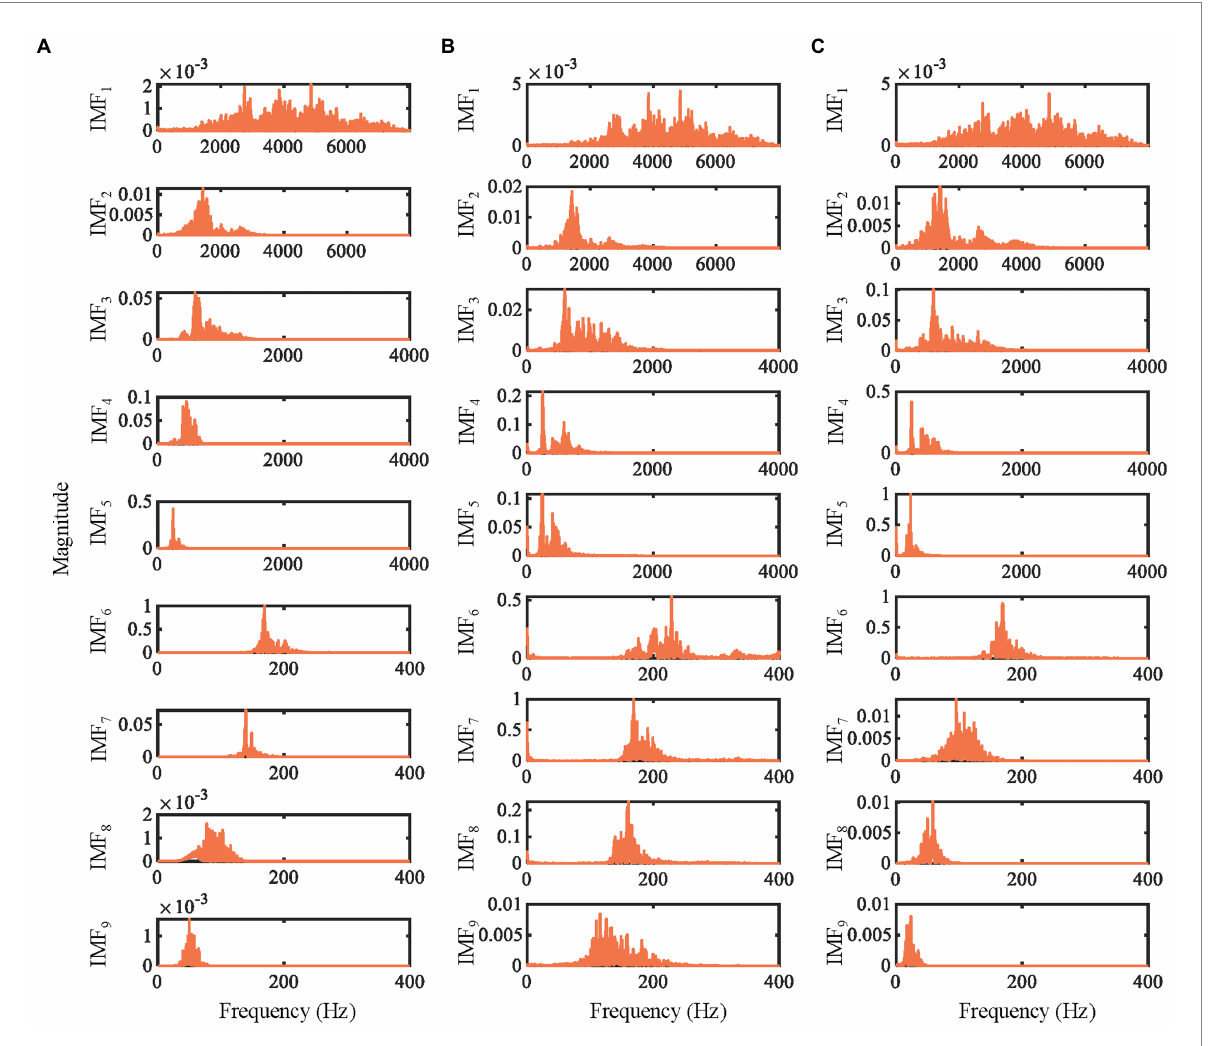
FIGURE 5 The power spectra of the first 9 IMFs obtained by decomposing the emotional speech signal by different methods. (A) IMEMD. (B) ICEEMDAN. (C)